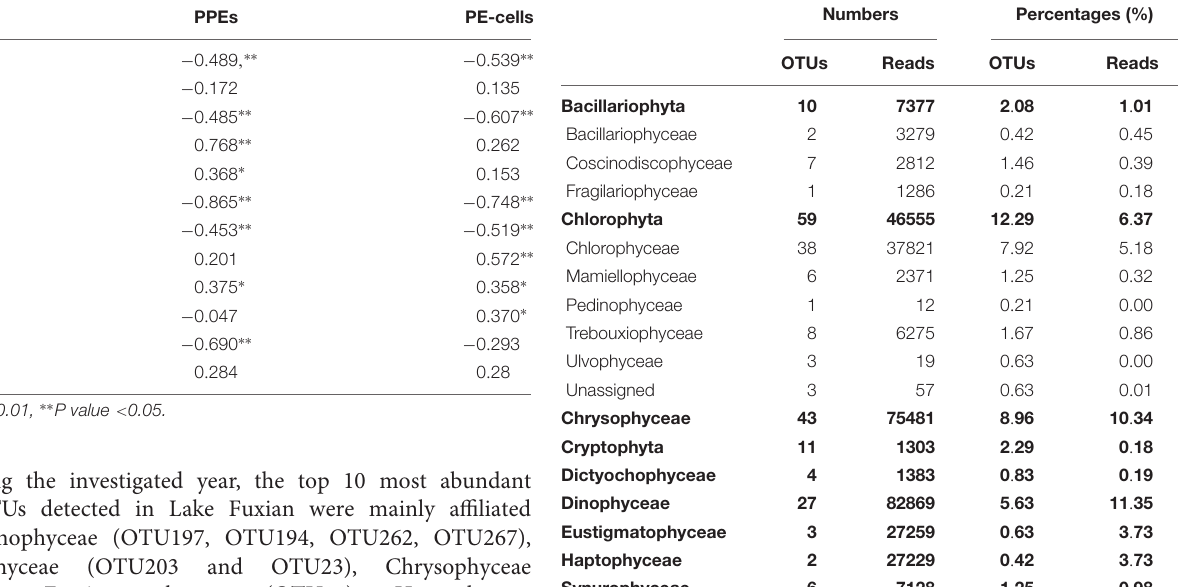
TABLE 3 | Taxonomic composition of putative photosynthetic picoeukaryotes TABLE 2 | The correlations between environmental factors and the abundance of retrieved in Lake Fuxian. picophytoplankton. PPEs PE-cells